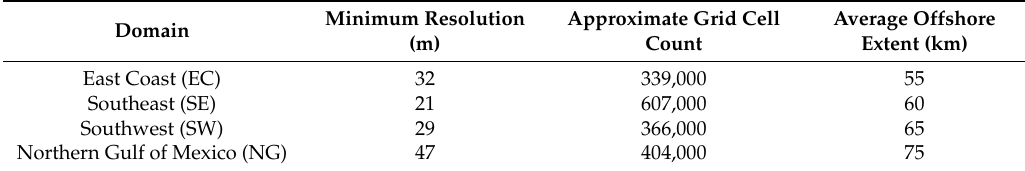
Table 1. Characteristics of Advanced Coastal Modeling System (ACMS) model